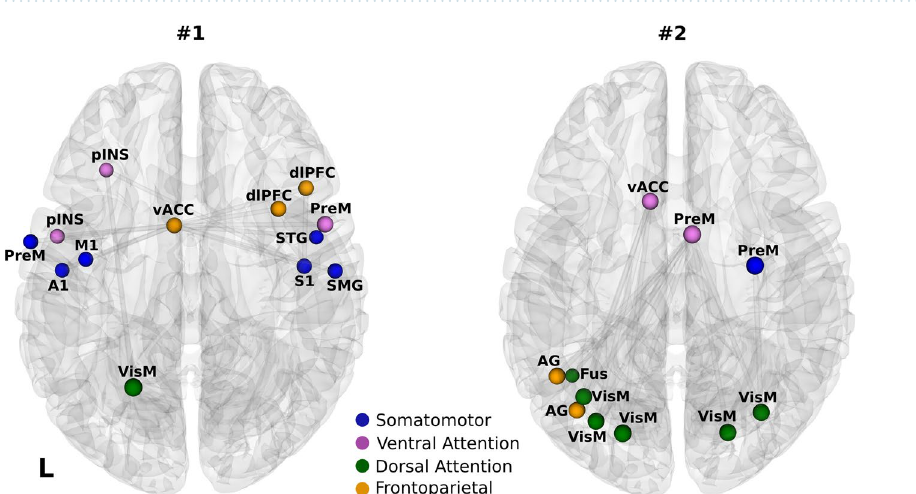
Figure 2. Athletes showed higher rsFC than non-athletes in two distinct network components. Network component #1 consisted of 13 nodes and 13 edges, and network component #2 consisted of 11 nodes and 13 edges, and were distributed across the somatomotor, dorsal/ventral attention and frontoparietal networks. Nodes are color-coded according to the 7 Yeo network parcellation 54 . Somatomotor (blue), ventral attention (magenta), dorsal attention (orange) and frontoparietal (pink) networks. pINS—posterior insula, dlPFC— dorsolateral prefrontal cortex, vACC—ventral anterior cingulate cortex, M1—primary motor cortex, PreM— premotor cortex, VisM—visuomotor cortex, S1—primary sensory cortex, A1—primary auditory cortex, SMG— supramarginal gyrus, STG—superior temporal gyrus, AG—angular gyrus, Fus—fusiform